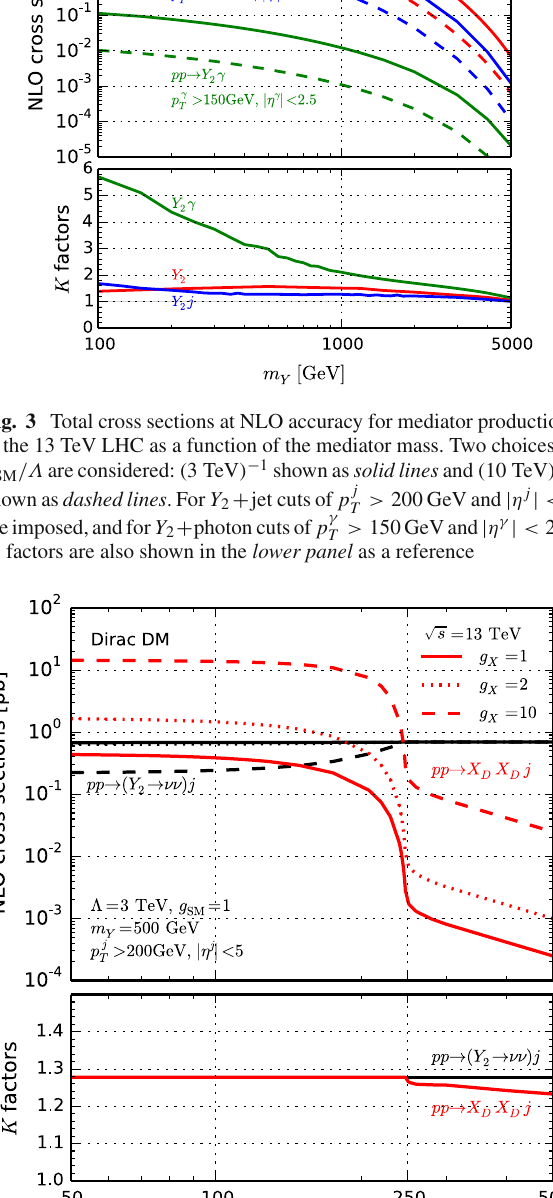
Fig. 4 Total cross sections at NLO accuracy for monojet final states with g X = 1 ( solid ), 2 ( dotted ) and 10 ( dashed ) for m Y = 500 GeV as a function of the DM mass, where we take Λ = 3 TeV and g SM = 1 and > 200 GeV and | η j | < 5. The red lines are for the (Dirac) impose p j T DM channel, the black lines for the neutrino. K factors are also shown in the lower panel as a